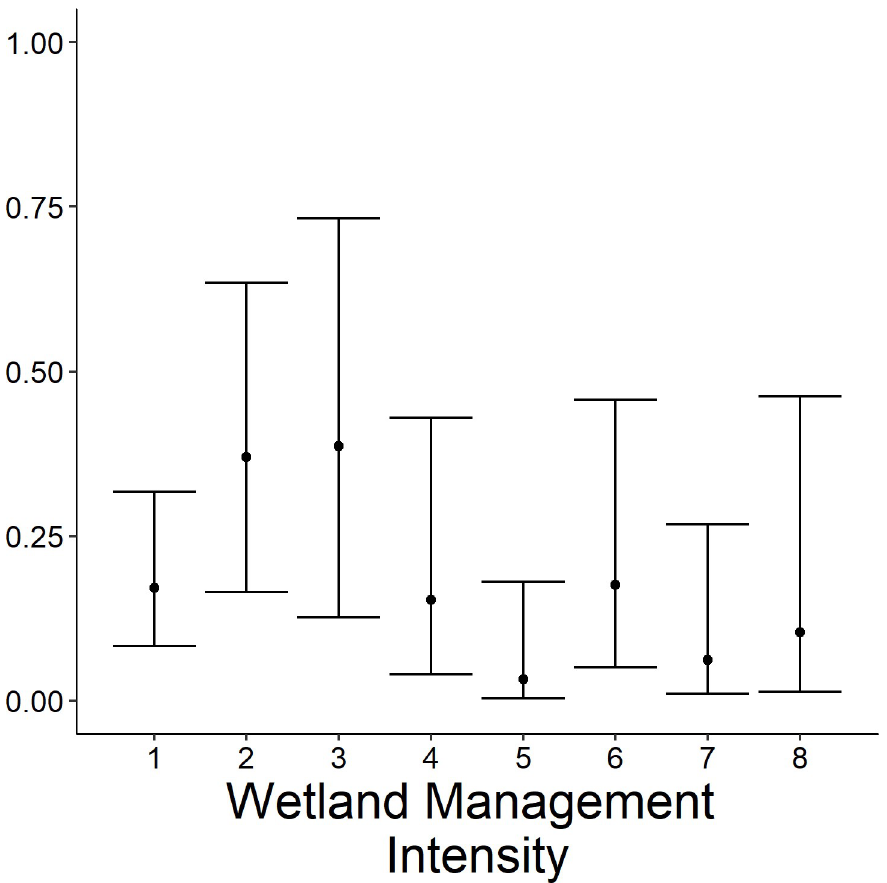
Fig 9. Predicted probability (95% confidence limits) of site occupancy for the emergent marsh bird group (American bittern, Botaurus lentiginosus ; least bittern, Ixobrychus exilis ; sora, Porzana Carolina ; king rail, Rallus elegans ; virginia rail Rallus limicola , and yellow rail, Coturnicops noveboracensis ) across wetland management intensity in Illinois during late spring and early summer